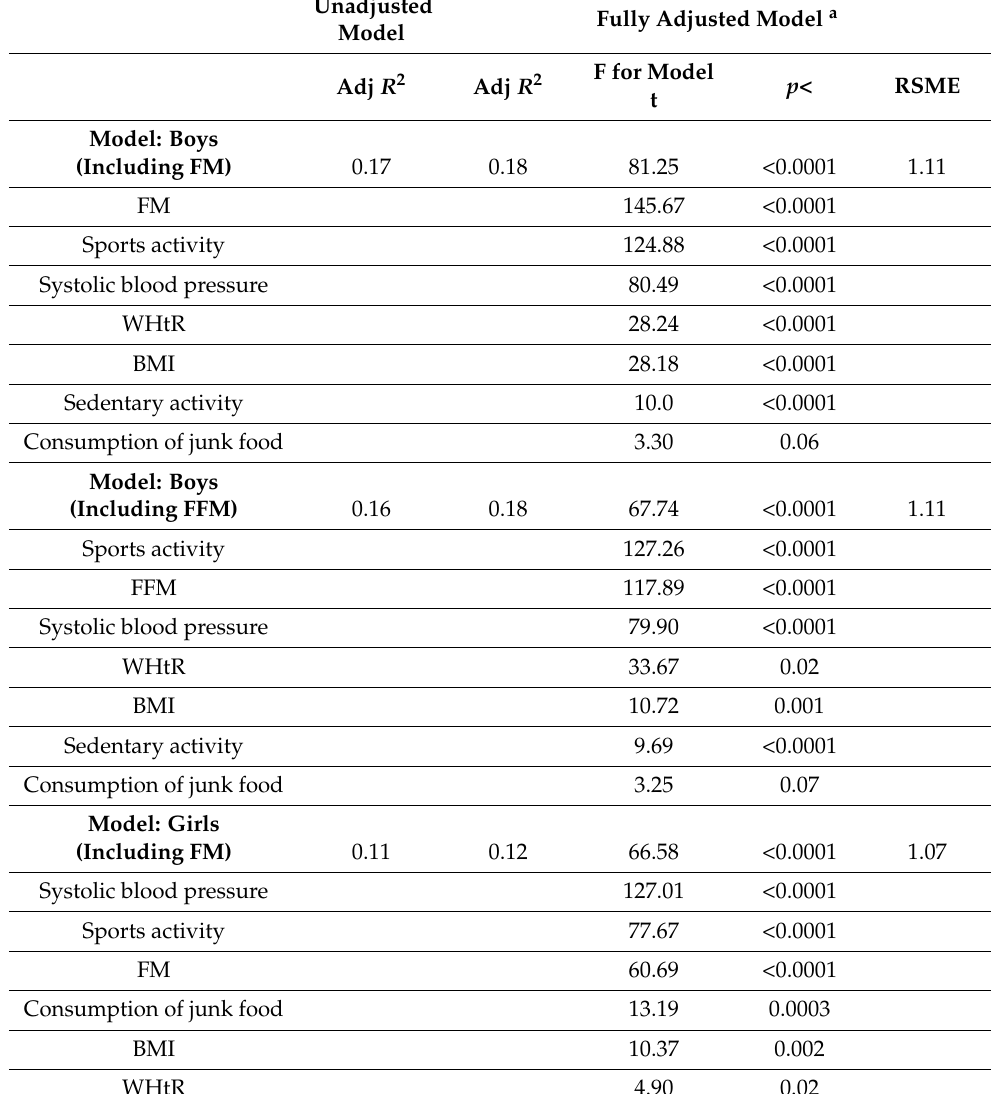
Table 3. Results of backward regression analysis of factors associated with cardiorespiratory fitness (CRF) presented in order of magnitude and comparing models entering FM vs.